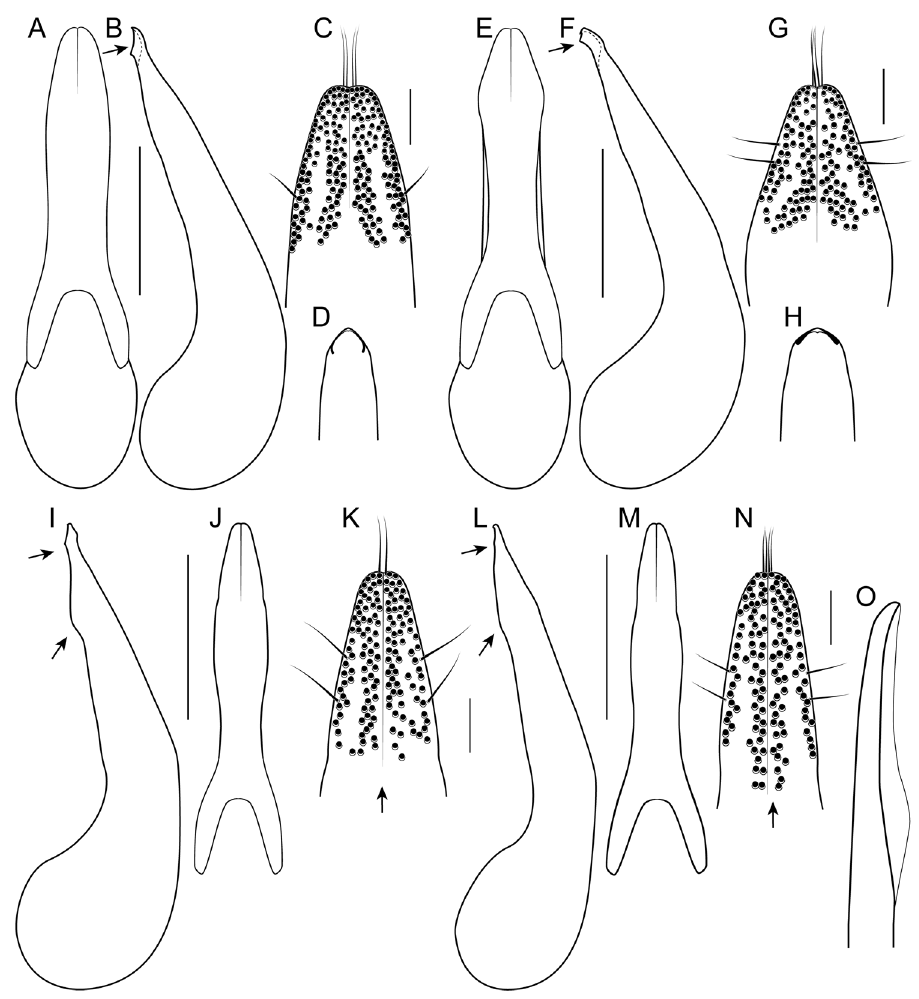
Figure 9. Bolitogyrus cyanipennis (Zheng) ( A–D ), B. kitawakii Smetana & Zheng ( E–H ), B. nigerrimus Yuan et al. ( I–K ) and B. metallicus Cai et al. ( L–O ). Aedeagus in parameral view ( A, E ), median lobe in lat- eral view ( B, F, I, L ), peg setae of paramere ( C, G, K, N ), apex of median lobe in parameral view ( D, H ), paramere ( J, M ), apical half of paramere in lateral view showing median ridge ( O ). Figures A–D , M–O modified from Cai et al. (2015). Scale bars: 0.5 mm ( A, B, D–F, H–J, L, M ), 0.1 mm ( C, G, K, N